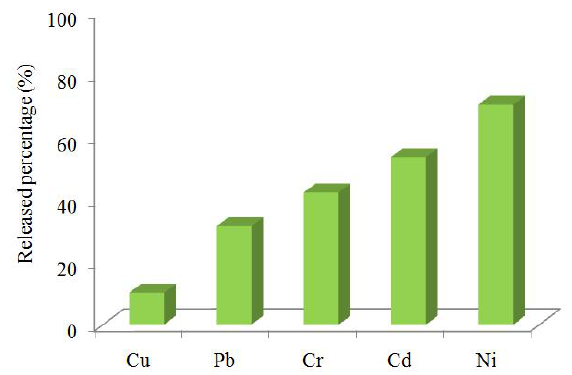
Figure 1. Released percentage of Cu, Pb, Cr, Cd, and Ni during tea brewing.